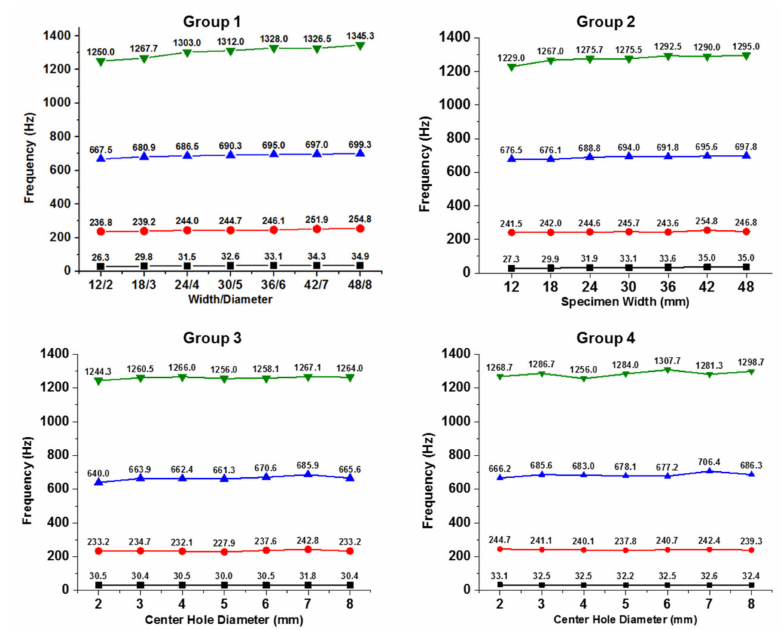
Figure 10. Natural frequency plots for all specimen groups and frequency modes. Mode 1 ( (cid:4) ), mode 2